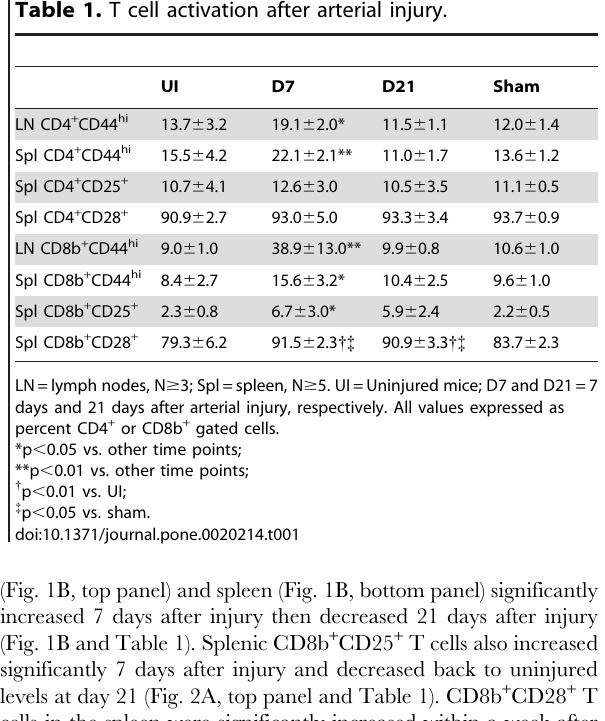
Table 1. T cell activation after arterial